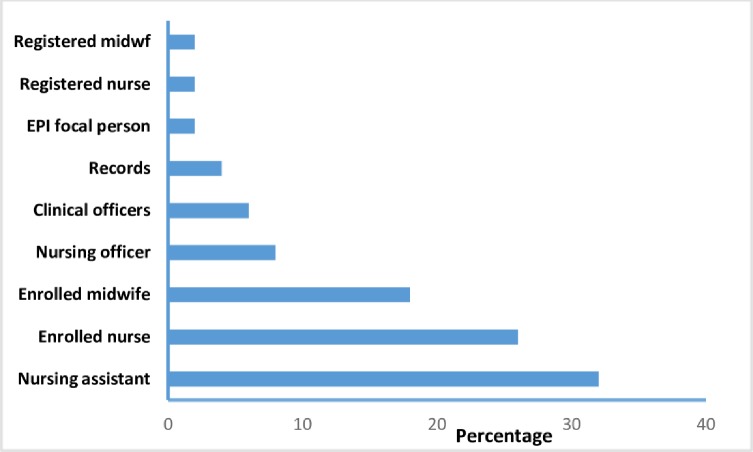
Graph showing percentage of respondents by category during 2015 immunization data quality audit, Kabarole District, Uganda.